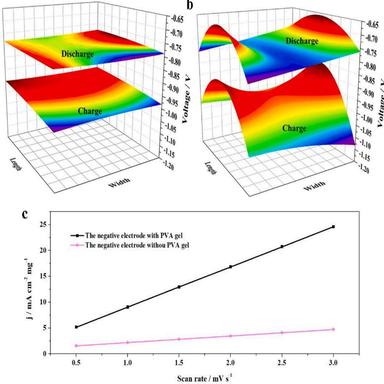
(a-b) and (c) the potential distribution and electrochemical active area of the coated carbon with and without PVA gel after cycling at 1 A g− 1 .